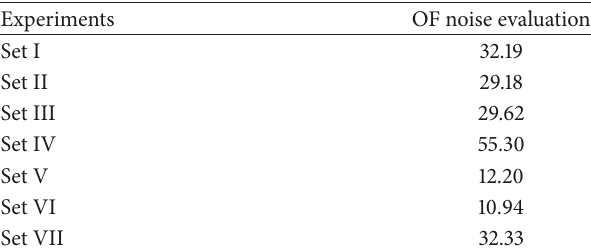
Table 5: Evaluation of the OF noise (average absolute difference of two following OF values for a mono-dimensional scan between seed and true